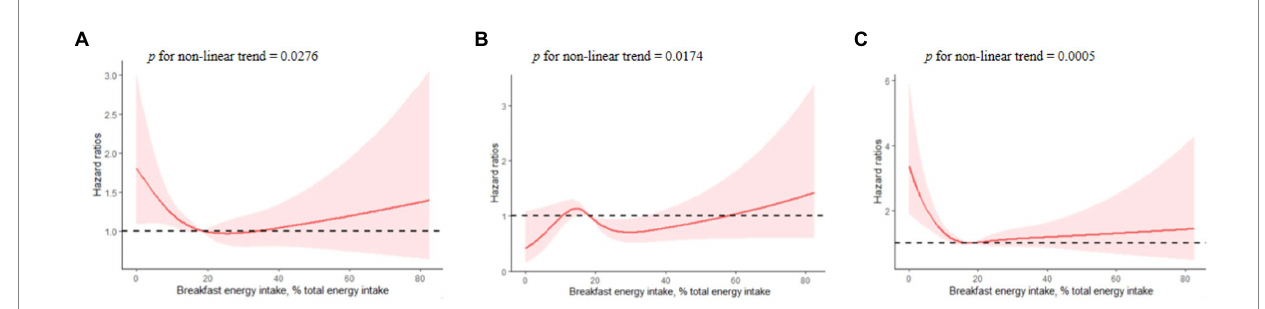
FIGURE 2 Multivariable-adjusted hazard ratios of association between breakfast energy intake and cardiovascular events [ (A) major cardiovascular events; (B) myocardial infarction; (C) new-onset stroke]. A knot is located at the 5th, 35th, 65th, and 95 th percentiles for energy intake at breakfast. The model was fully adjusted for age, gender, urban or rural location, education level, income, physical activity, smoking status, alcohol intake, BMI, history of hypertension, diabetes, total intake of energy, SFA, grains, vegetables, and dietary fiber, with household identification as random intercepts.